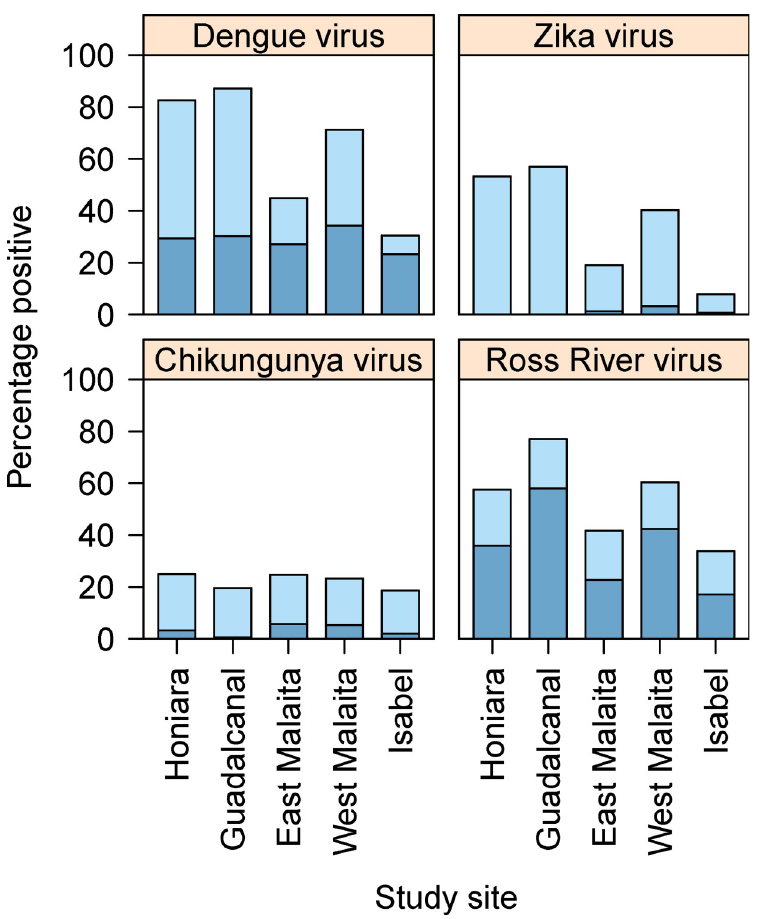
Fig 5. The seroprevalence of flaviviruses and alphavirus across different study sites in the Solomon Islands. The darker blue colour represents samples that were positive for that particular virus alone. The lighter blue colour represents samples that were positive for both of the flaviviruses (dengue and Zika) or both of the alphaviruses (chikungunya and Ross